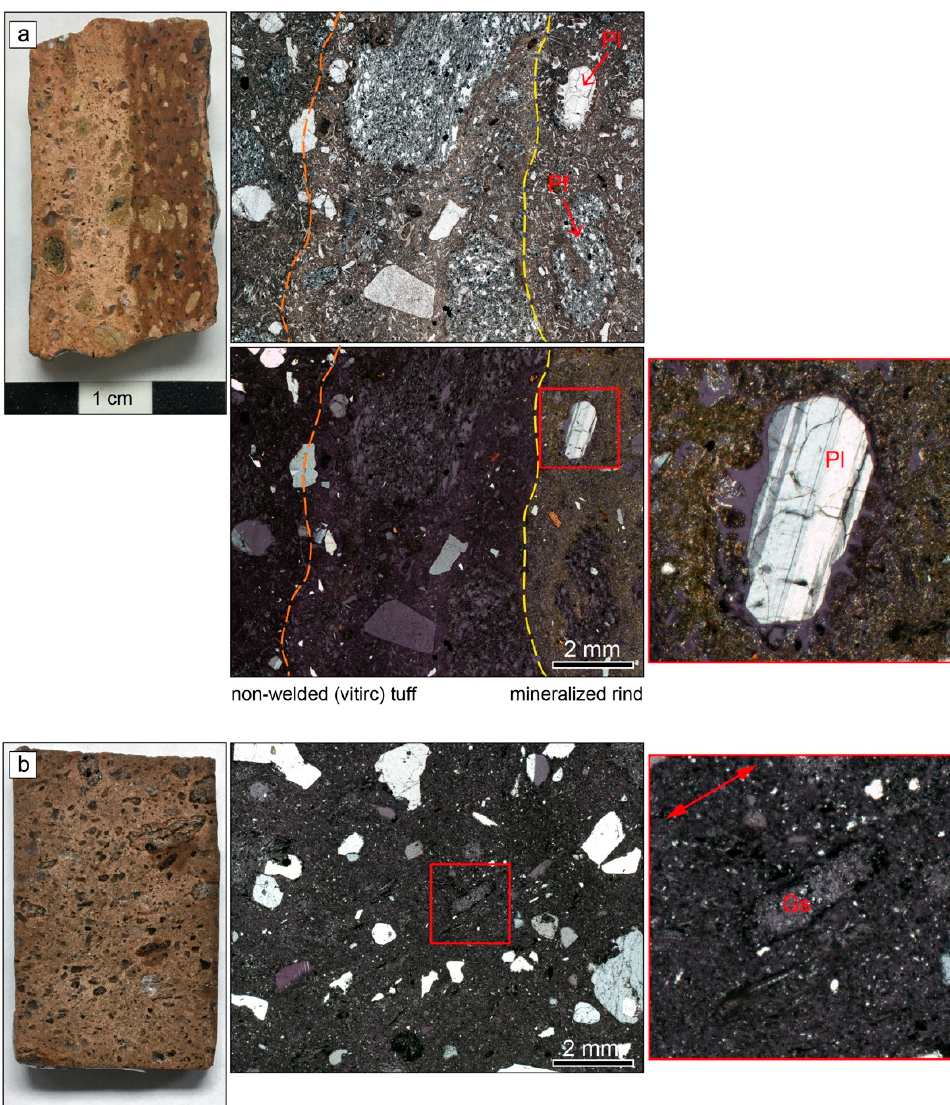
Figure 7. Lithological observations of the Bishop Tuff showing images of the hand sample on the left, general photomicrograph in the center, and magnified view in the right for one example of both Ig2E and Ig1E. ( a ) Hand sample (left) of fumarolic rind of Ig2Ec, showing transition from left to right of unaltered to vapor-phase altered tuff to form a 10 mm thick rind. Photomicrographs (center) in plane and crossed-polarized light, showing extent of alteration in the form of microcrystalline quartz. The yellow dashed line indicates the extent of the microcrystalline quartz matrix that is most notably visible in cross-polarized light. The orange dashed line demarcates the extent of a bleached zone that is only apparent in plane polarized light and hand sample. Note the apparent alteration of microcrystalline quartz in the void space of pumice fragments (Pf) in the silicified rind. Magnified view (right) of the fumarolic rind in crossed-polarized light. A plagioclase grain (Pl) is rimmed by recrystallized glass and birefringent microcrystalline quartz. ( b ) Hand sample (left) of Ig1E showing flattened pumice, quart, and feldspar phenocrysts. Photomicrograph (center) of welded and devitrified portion of tuff under cross-polarized light showing alignment and flattening of glass shards and mineral grains that indicate that the tuff is welded. Magnified view of tuff matrix (right) under crossed-polarized light, showing how the flattened glass shards (Gs) have been crystallized to quartz and display axioltic texture inwards from the shard walls. The flattening is indicated by the red double-arrow showing the direction of preferred alignment of the long axes of elongate grains.